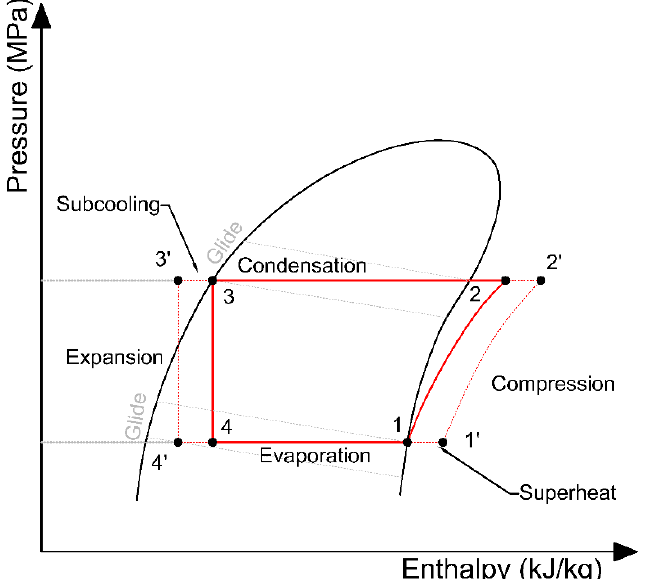
Figure 2. Log p-h diagram of the vapour-compression refrigeration cycle. Reprinted with permission from ref. [19]. 2017 Duarte et al.